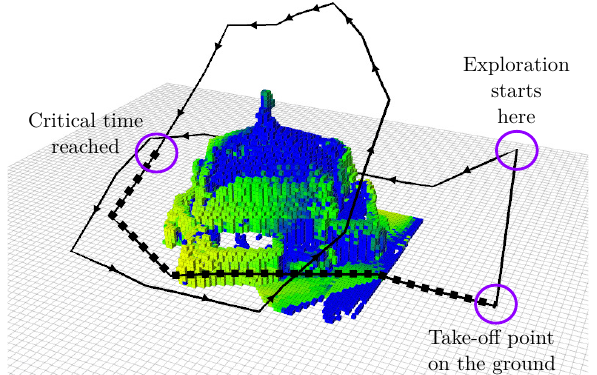
Figure 13. Path computed with the time-dependent cost function enabled. The square markers represent the path generated after the critical time, which moves the MAV back to the starting